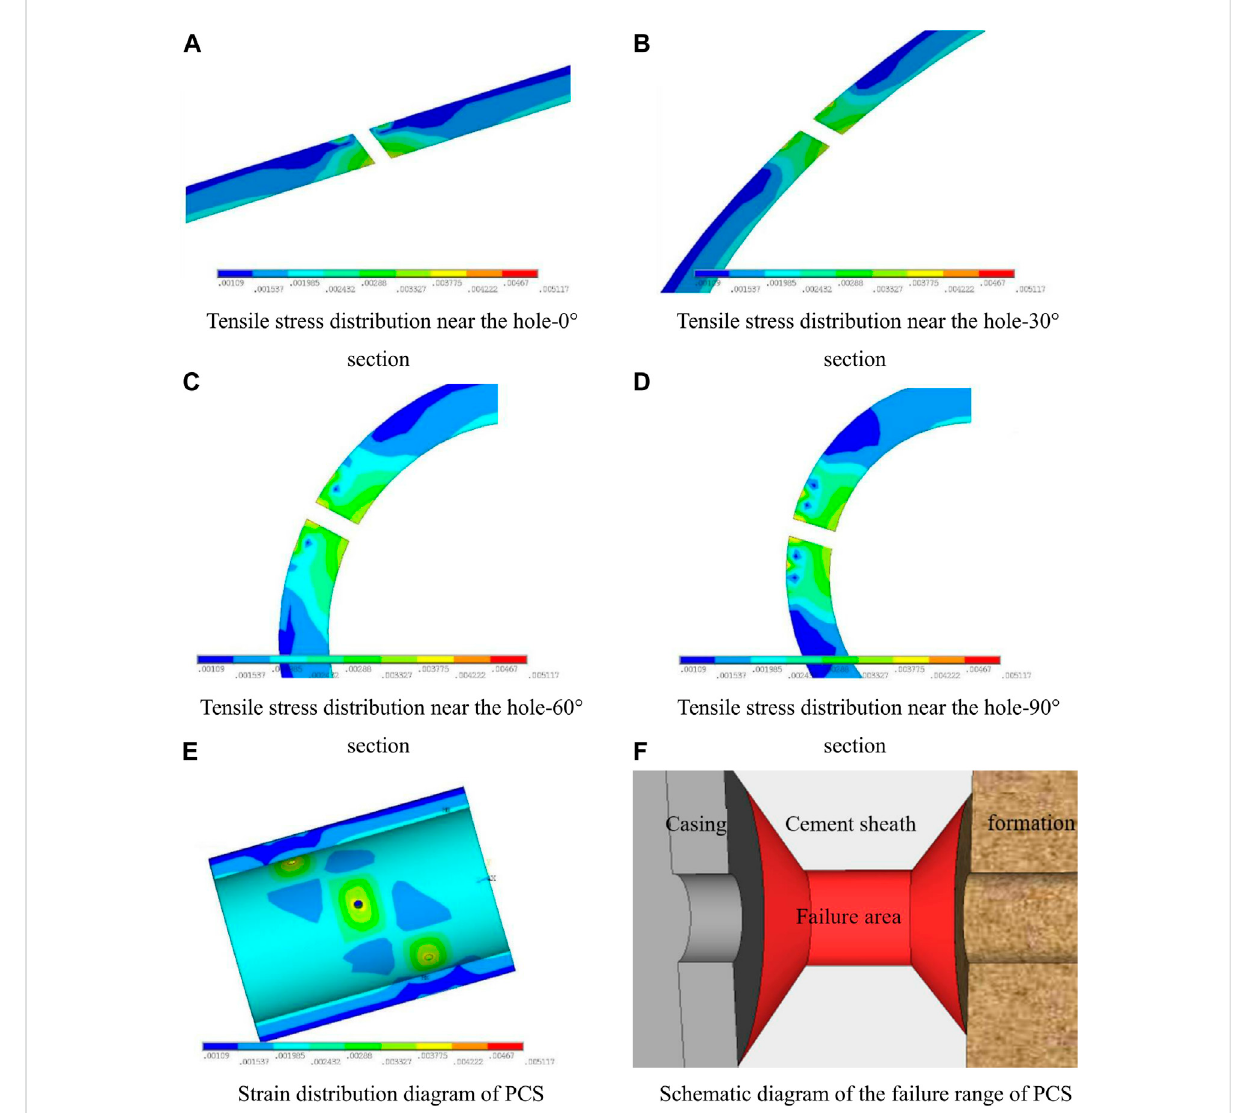
FIGURE 12 Distribution diagram of tensile stress and strain around the PH. (A) Tensile stress distribution near the hole-0 section. (B) Tensile stress distributionnearthehole-30section. (C) Tensilestressdistribution nearthehole-60section. (D) Tensilestressdistribution nearthehole-90section. (E) Strain distribution diagram of PCS. (F) Schematic diagram of the failure range of